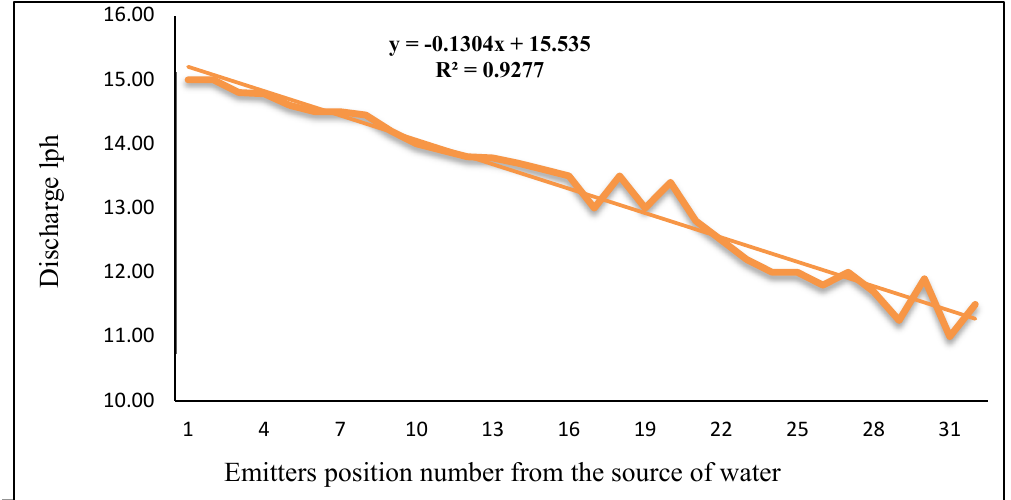
Figure 13. ( a ) Discharge variation of selected emitters of the drip irrigation system in URTA.